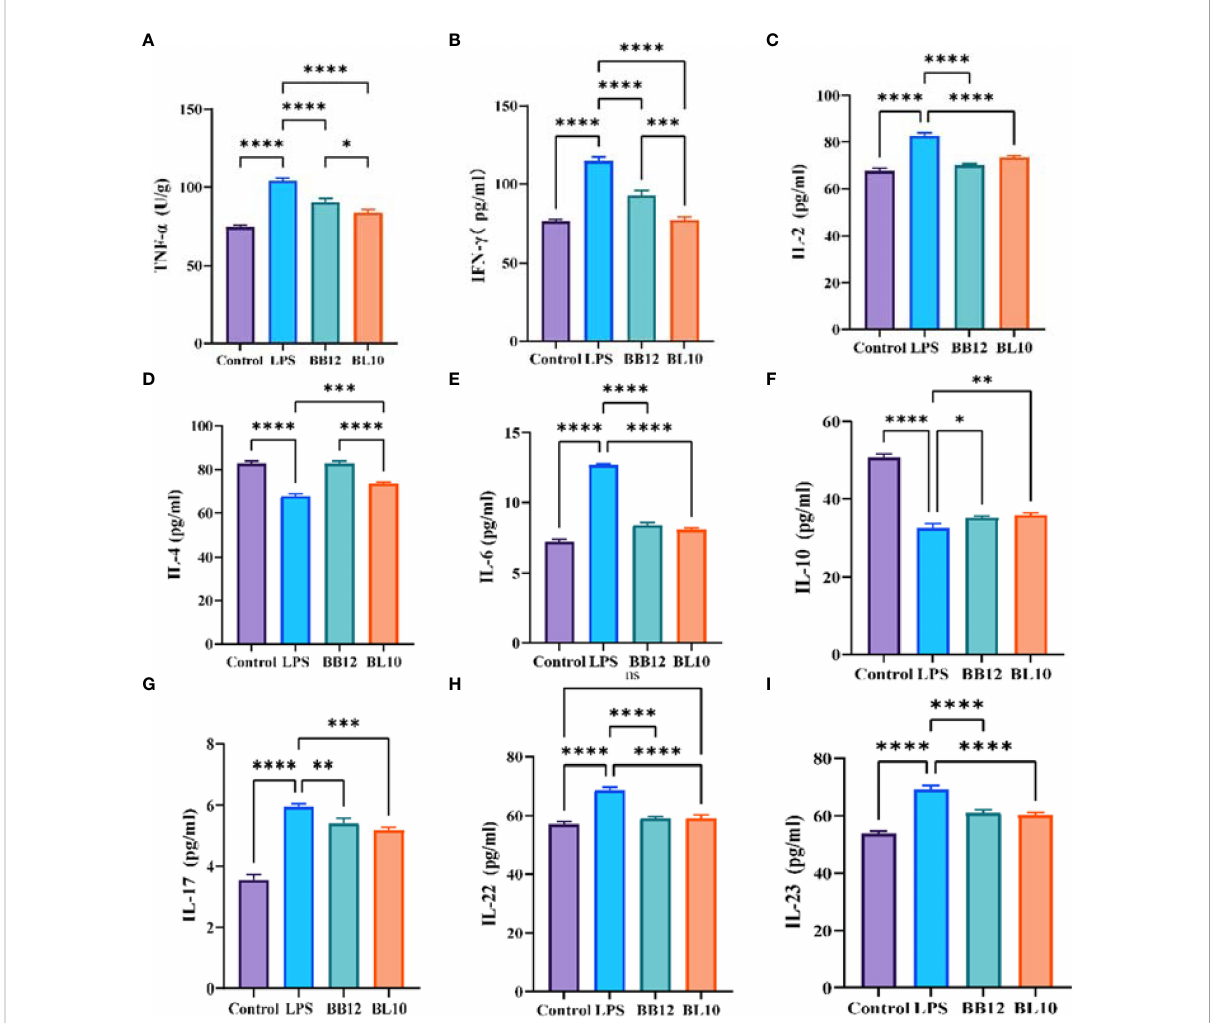
FIGURE 6 Effect of B longum BL-10 on ileal in fl ammatory factor. (A) TNF- a ; (B) IFN- g ; (C) IL-2; (D) IL-4; (E) IL-6; (F) IL-10; (G) IL-17; (H) IL-22; (I) IL-23. All data are expressed as mean ± SD (n=3). Values with a different superscript letter (*, **, ***, **** and ns) were signi fi cantly different at p <0.05, p <0.01, p <0.001, p <0.0001 and p